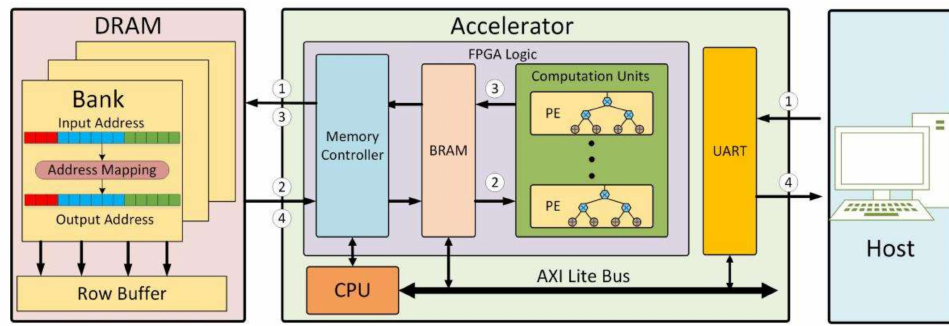
Figure 4. Workflow of the convolutional neural network (CNN)